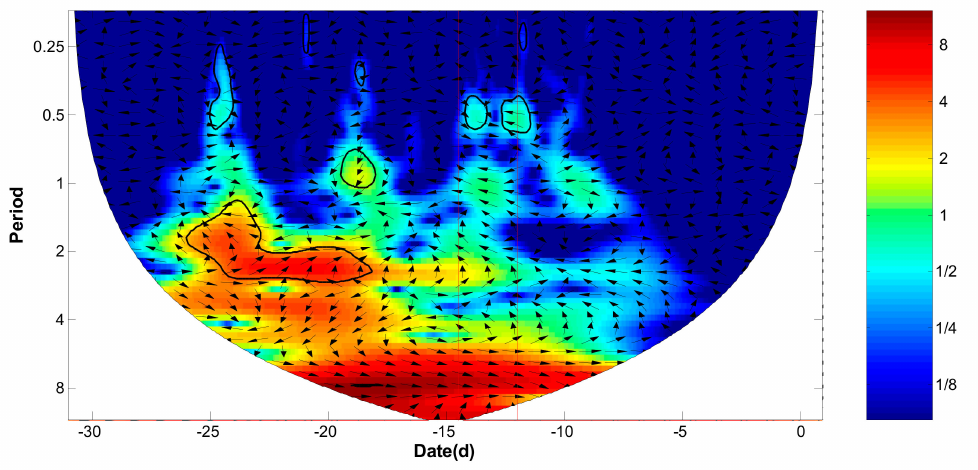
Figure 10. Cross-wavelet spectrum on correlation for ∆ TEC and Vsw, where the interval in red vertical lines represents period-1.